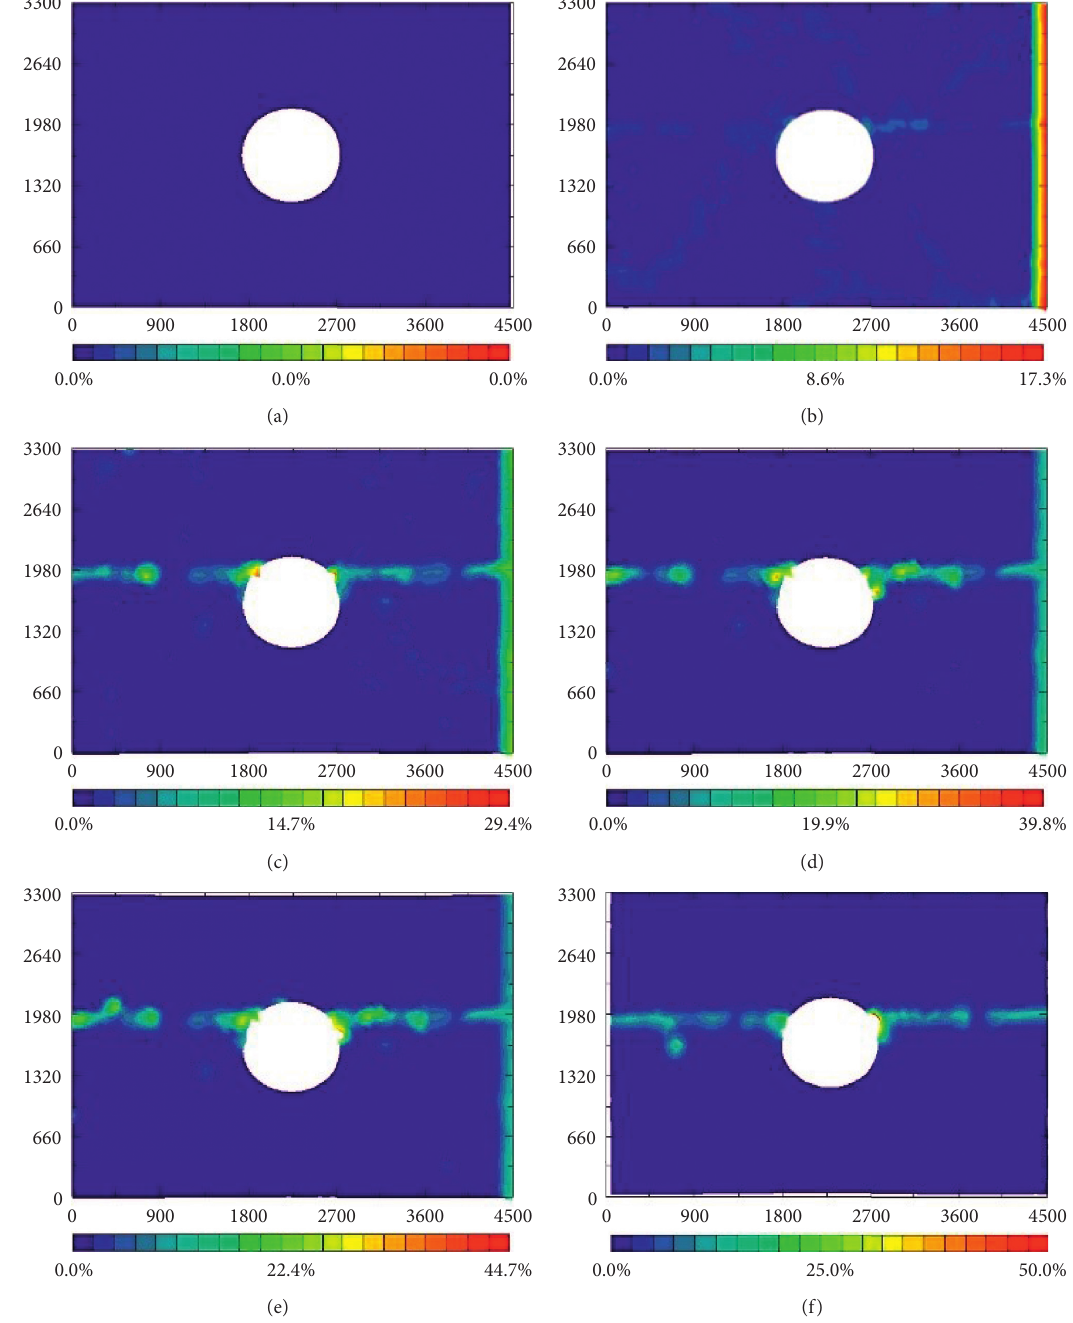
Figure 12: Horizontal displacement cloud map of unsupported model. (a) 0.25 MPa. (b) 0.40MPa. (c) 0.47MPa. (d) 0.51MPa. (e) 0.52MPa. (f)